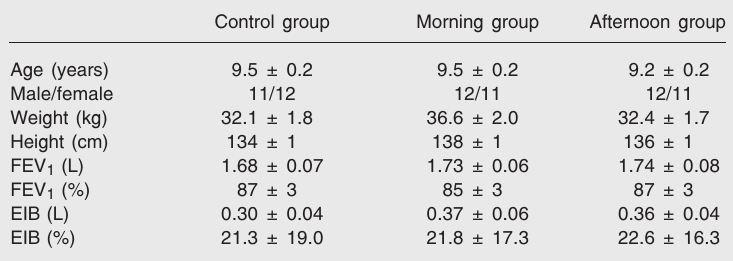
Data are reported as means ± SEM for 23 subjects in each group. EIB (L) = exercise- induced bronchospasm (maximum fall in FEV 1 ); EIB (%) = exercise-induced broncho- spasm reported as percent fall.